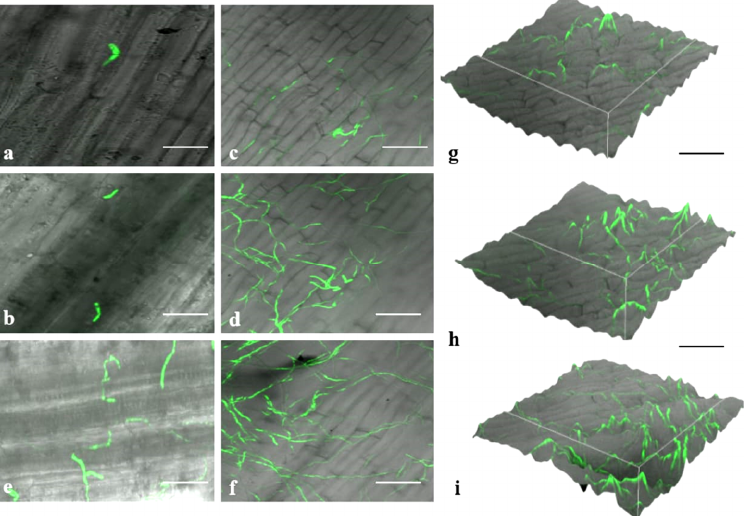
Figure 11. Different stages of colonization of tagged Fox R1 in root cells of saffron. ( a ); Germinating spores at 12 hpi, ( b ); germinating spores entering the vascular tissue, ( c ); Fox R1 hyphae start colonizing the root surface and hyphae attached themselves to root surface along the junction of epidermal cells at 1 dpi, ( d ); 5 dpi mycelia covered the root surface and formed mesh of hyphae, ( f ); at 10 dpi, elongated hyphae were observed, ( e ); hyphae entering the xylem tissue, ( g , h , i ); are the corresponding 3-D images of infected roots at 1,5,10 dpi respectively Each bar represents 10 µ